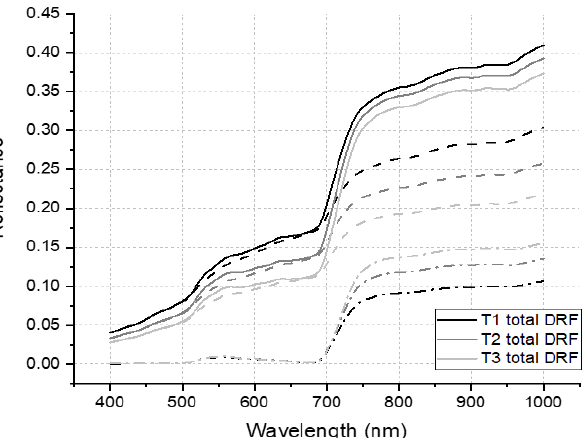
Figure 13. Reflectance of the three stages in the spectral range 400–1000 nm (dashed line: single scattering, dashed dot: multiple scattering).